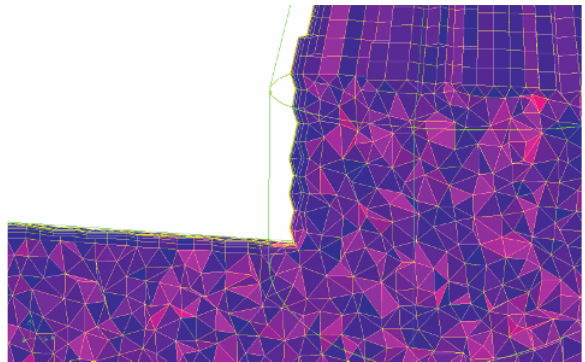
Figure 2: Combined mesh elements type in the pipe system